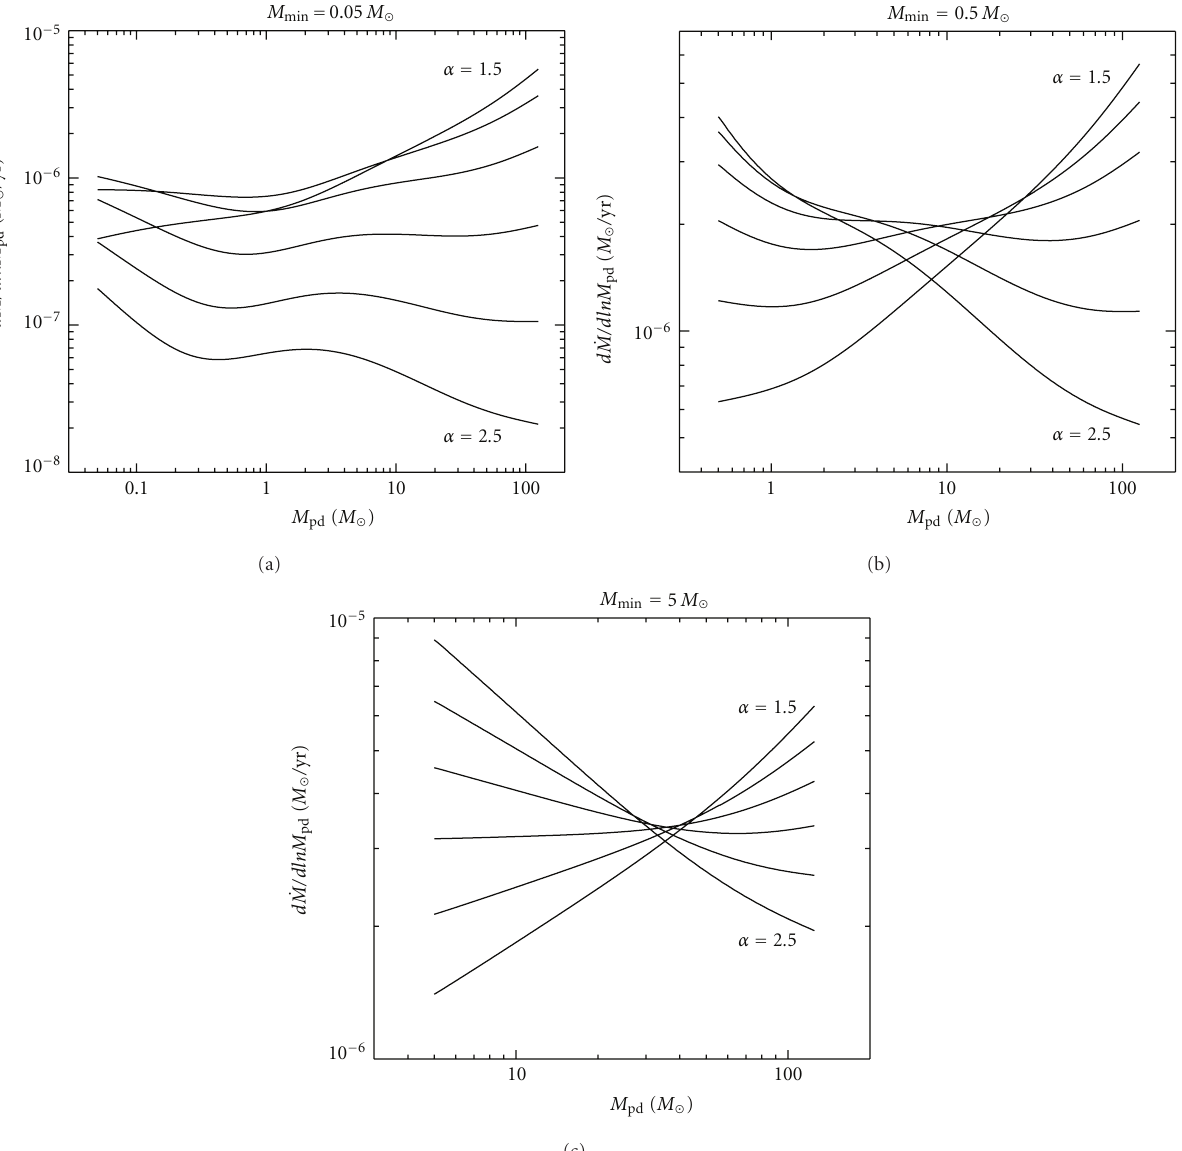
Figure 11: The amount of mass loss per logarithmic mass interval of the perturbed star as a function of the perturbed star’s mass. Each line was calculated with a di ff erent PDMF. The titles in each panel indicate the value of M min used for that panel. In each panel, α goes from 1.5 to 2.5 in even increments of 0.167, and for each line M max = 125 M (cid:5) . Bagano ff et al. [22] into (25), we find ˙ M ∼ 10 − 5 M (cid:5) yr − 1 . This value is consistent with the mass inflow rate at ∼ 1 (cid:3)(cid:3)